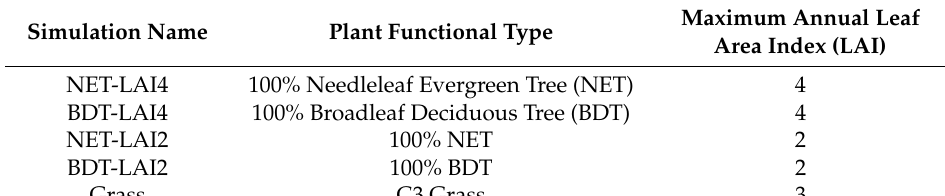
Table 1. The five simulations run using the Community Earth System Model 1.2.0.